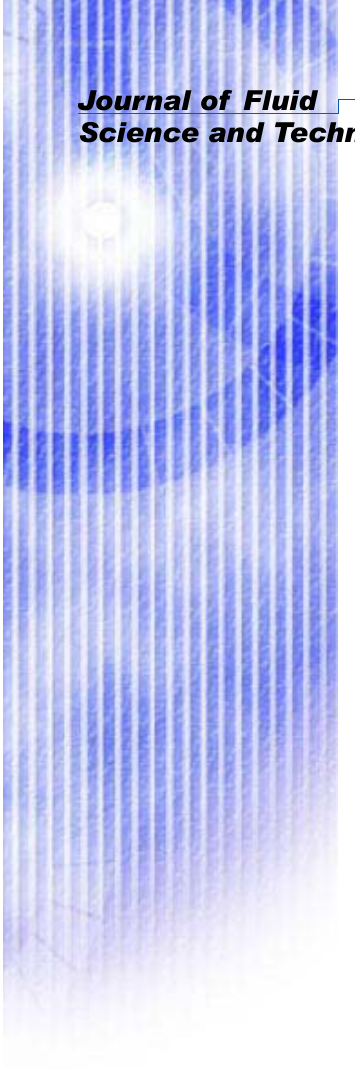
ussian PDF), the joint PDF of the real (u`) and imagin